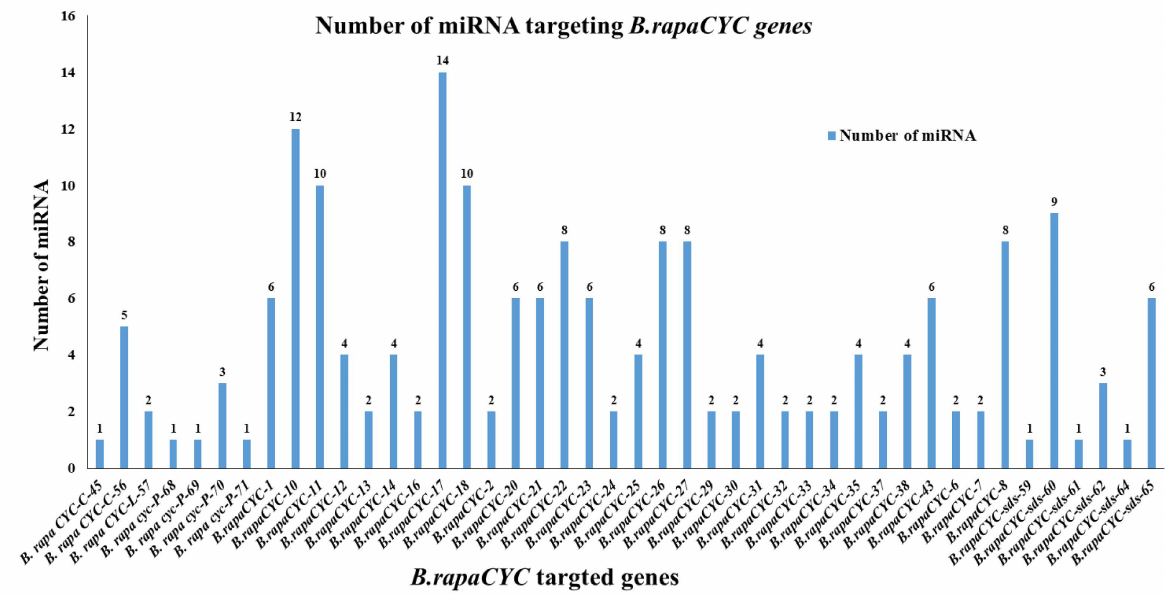
Figure 7. Graphical description of the miRNA targeting cyclin genes in Brassica rapa